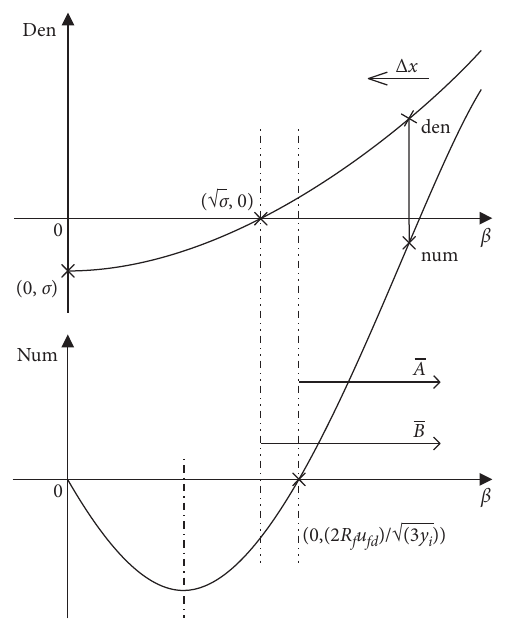
Figure 10: UABOT’s configuration of each cycle in the physical experiment. (a) Variations of x of x f and L s in the 2 nd experiment. (c) Variations of x f and L s in the 3 rd experiment.